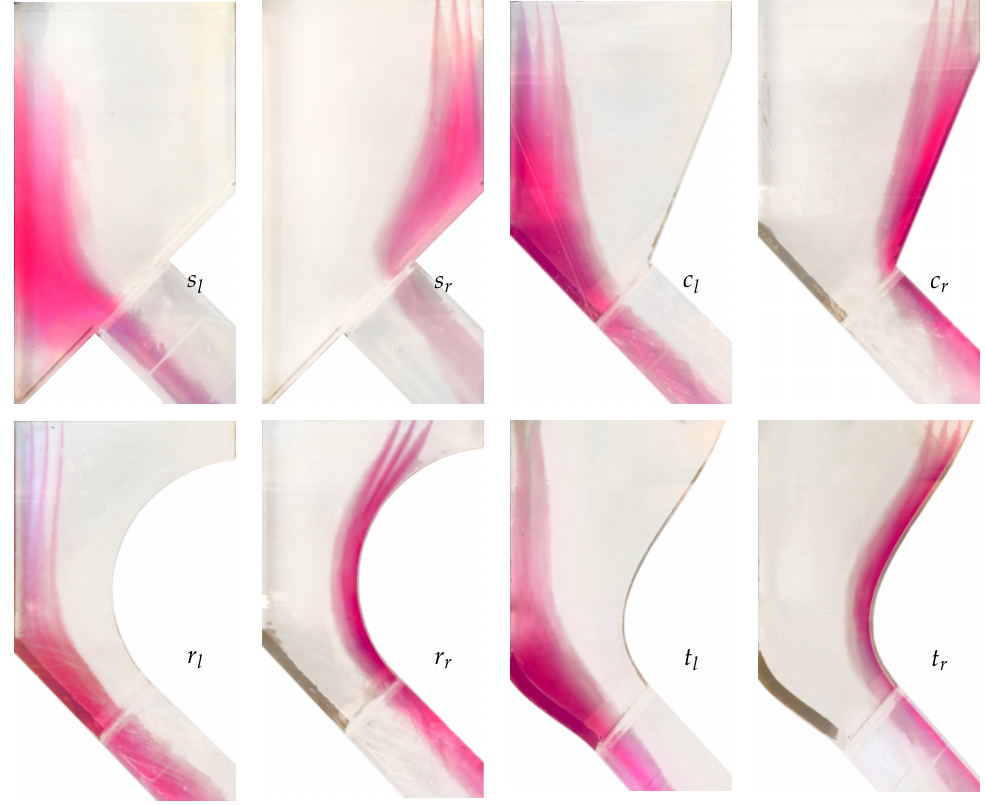
Figure 6. Results from the inlet experiments; pictures show a long exposure of the tracer at 5L · s − 2 ( t = 3 s); s = straight, c = chamfer, r = round, t = tangent; l = left, r = right.